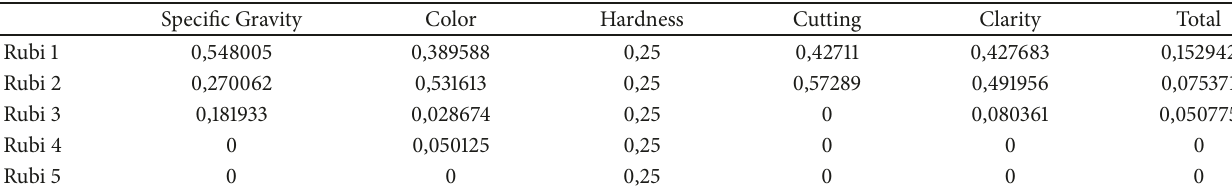
Table 9: Value of alternative calculation result on